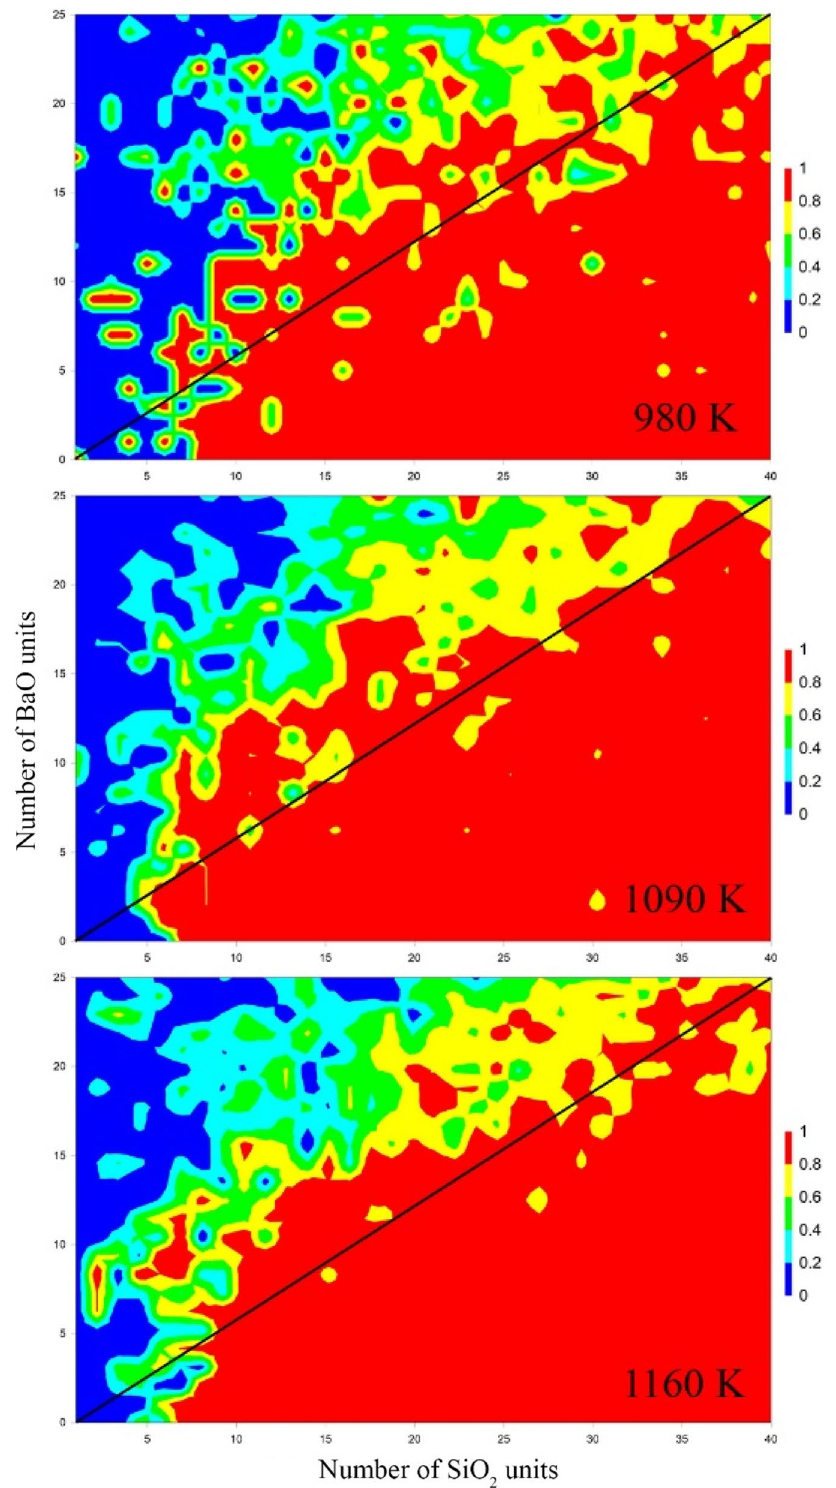
Figure 3. Spatial composition of the silica to total oxide ratio for all clusters studied. Temperatures are shown on the lower right side of the